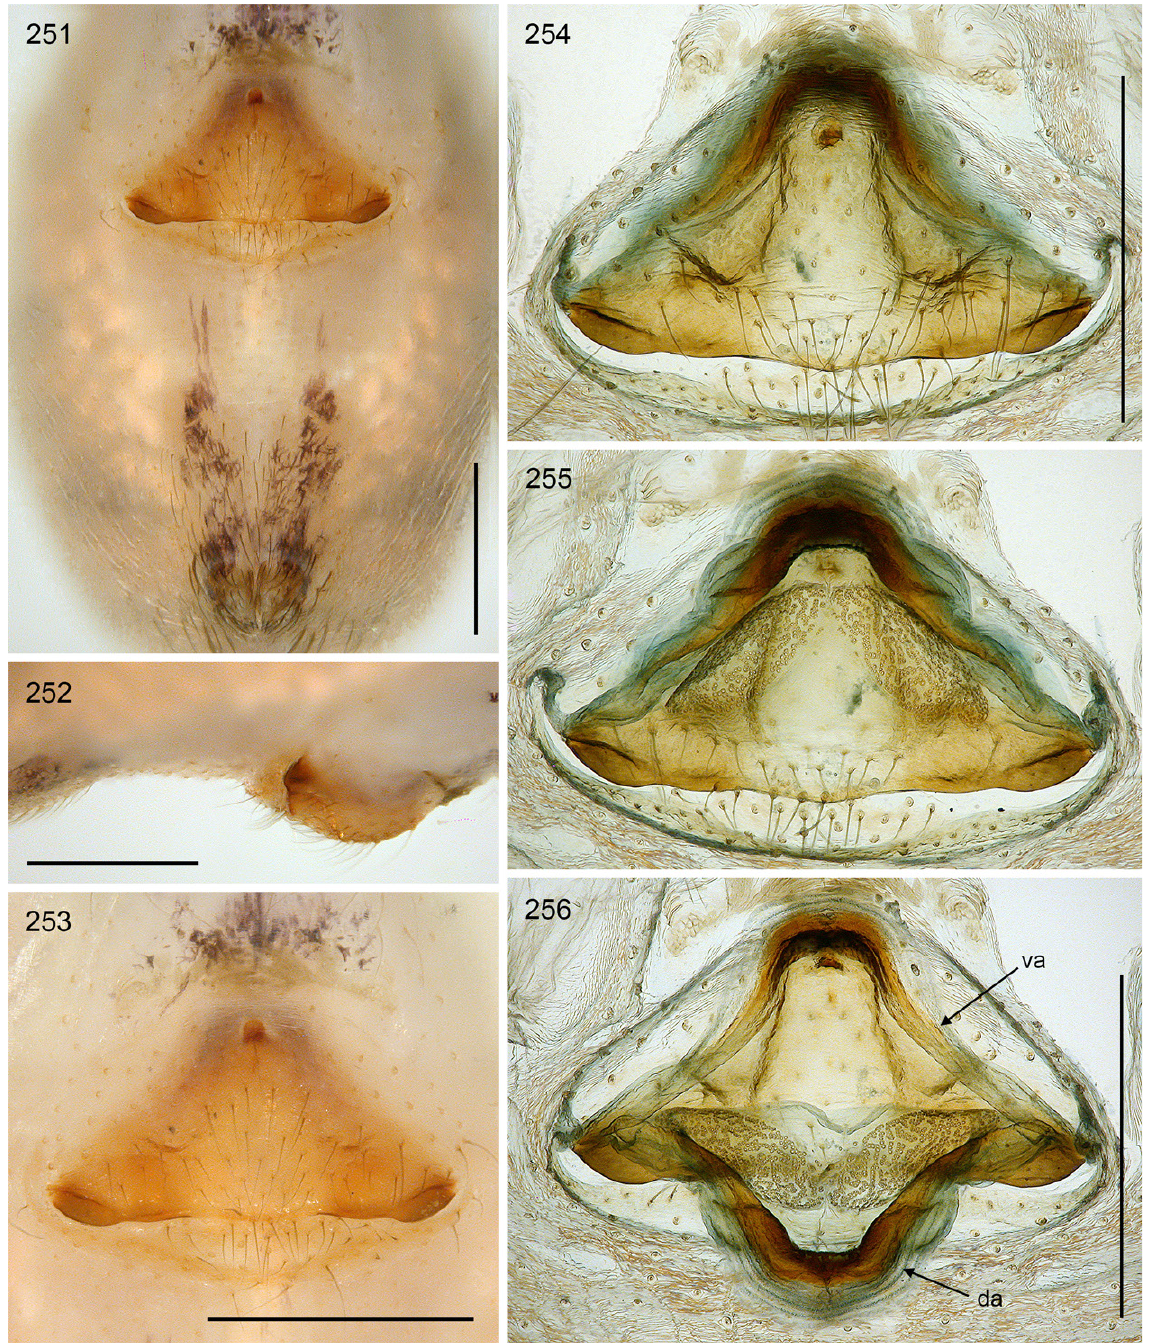
Figs 251–256. Maghreba nkob gen. et sp. nov.; female from Morocco, E of Nkob (ZFMK Ar 22374). 251 . Abdomen, ventral view. 252–253 . Epigynum, lateral and ventral views. 254–256 . Cleared female genitalia, ventral view, regular dorsal view, and dorsal view with dorsal arc tilted backwards. Abbreviations: da = dorsal arc; va = ventral arc. Scale bars = 0.5